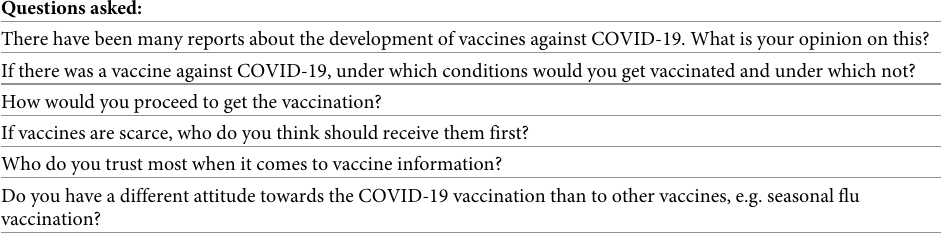
Table 2. Interview questions asked in T2 about